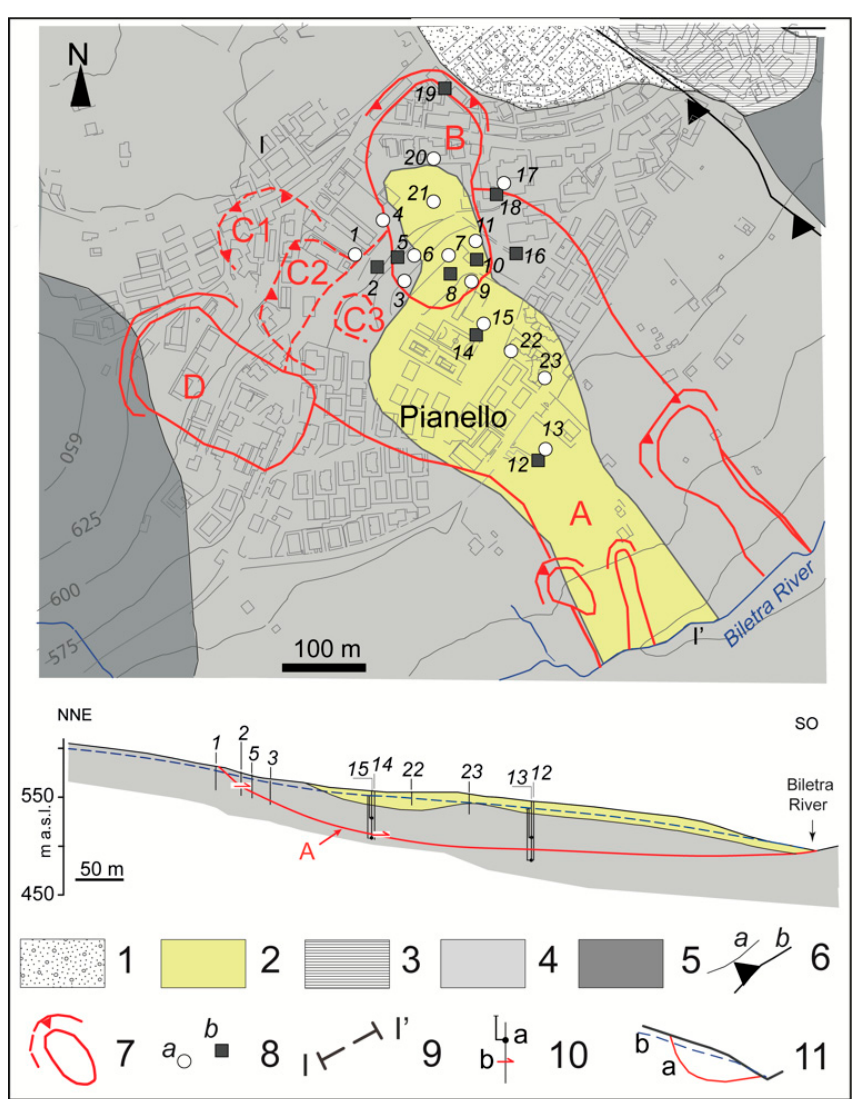
Figure 17. Pianello landslide (class 5 in Figure 11; Table 7): (1) debris; (2) remoulded clays; (3) Bovino Synthem; (4) Faeto Flysch (limestone member); (5) Faeto Flysch (clayey member); (6) stratigraphic contact (a) and over-thrust (b); (7) landslide crown (a) and body (b); (8) borehole with piezometers (a), borehole with inclinometer (b); (9) line of section; (10) piezometer cell with corresponding hydraulic heads (a) and inclinometer shear bending ( b ); (11) labelled landslide portions: crown (a), slip surface (b).